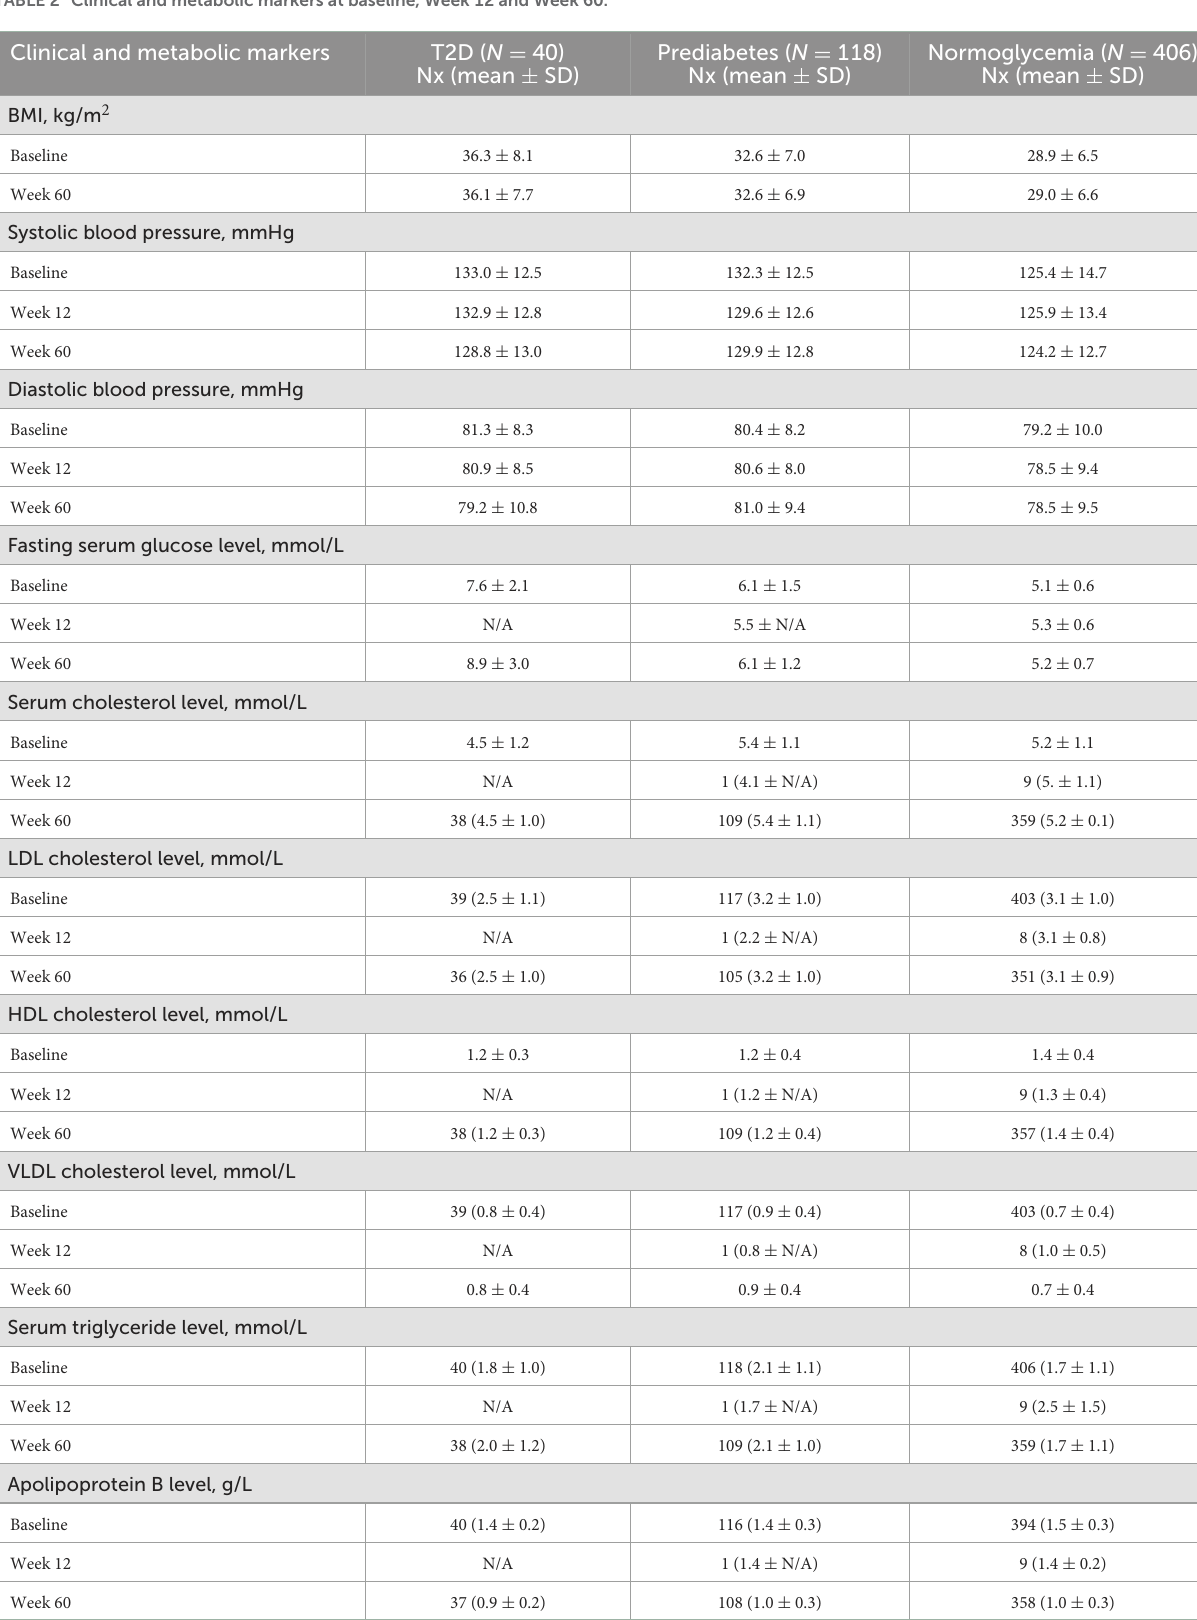
TABLE 2 Clinical and metabolic markers at baseline, Week 12 and Week